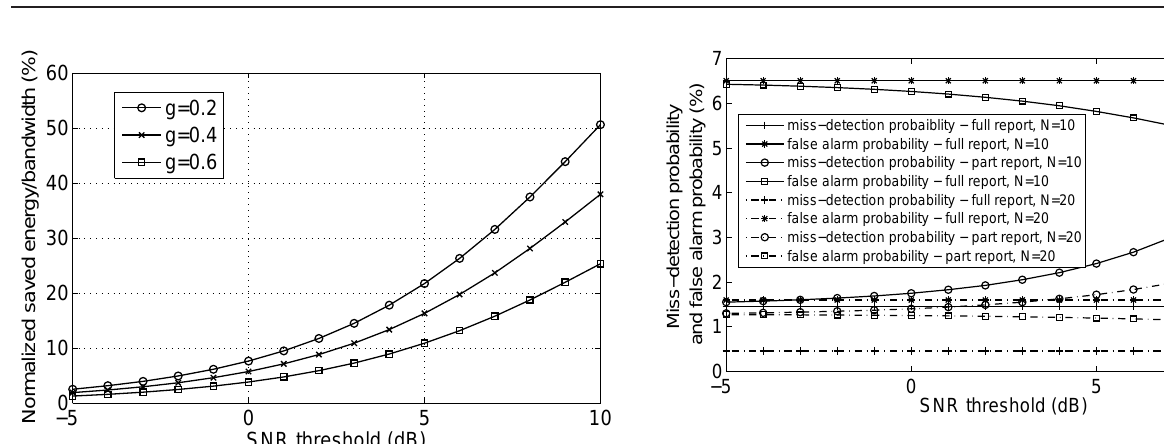
Figure 7. Fused miss-detection probability and fused false alarm probability at a R-CPE as function of the SNR threshold.